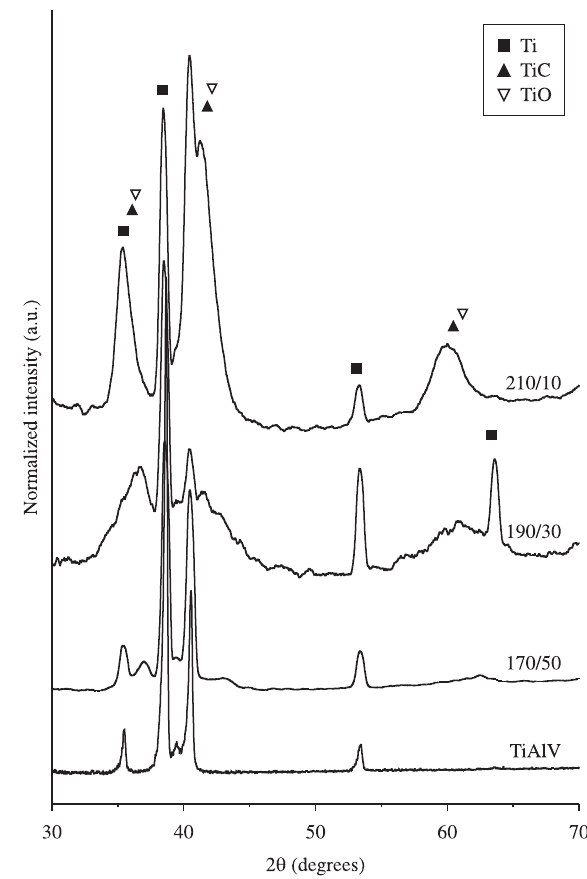
Figure 3. Grazing angle XRD results for TiAlV substrate and Ti-doped carbon coatings deposited with different (Ar/CH ) flows (in sccm). Incident 4 X-ray angle of Table 1. Contact depth ( h ), hardness ( H ), elastic modulus ( E ), and elastic c recovery ( ER ) of produced Ti-doped carbon films measured by nanoindentation flows. The 4 for a load ~ 2.55 mN (mean value ± standard deviation)*.